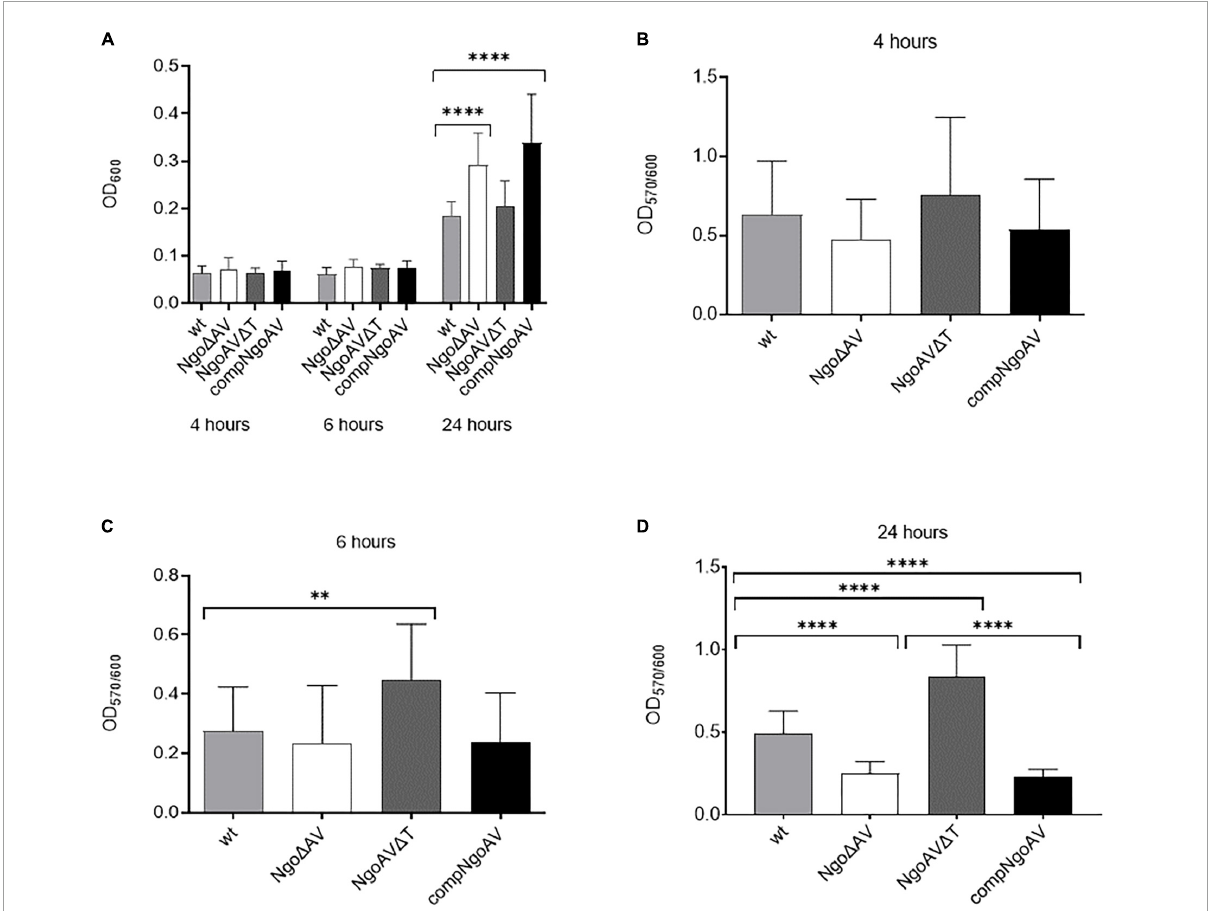
FIGURE3 Growth and biofilm biomass of N. gonorrhoeae mutants within M.NgoAV locus compared to the wt strain. Measurements were performed by estimating bacterial density (OD 600 ) and by staining with crystal violet (OD 570 ) after a 4-, 6-, and 24-h growth. (A) Biofilm and planktonic cell growth were determined by absorbance OD 600 ; (B) Biomass production: ratio of cells that form biofilm (OD 570 ) vs. total grown cells (OD 600 ) at 4 h. (C) Biomass production: ratio of cells that form biofilm (OD 570 ) vs. total grown cells (OD 600 ) at 6 h. (D) Biomass production: ratio of cells that form biofilm (OD 570 ) vs. total grown cells (OD 600 ) at 24 h. Asterisks represent statistically significant differences in comparison to the wt strain ( p < 0.05). Data are means of at least three independent experiments ( ±